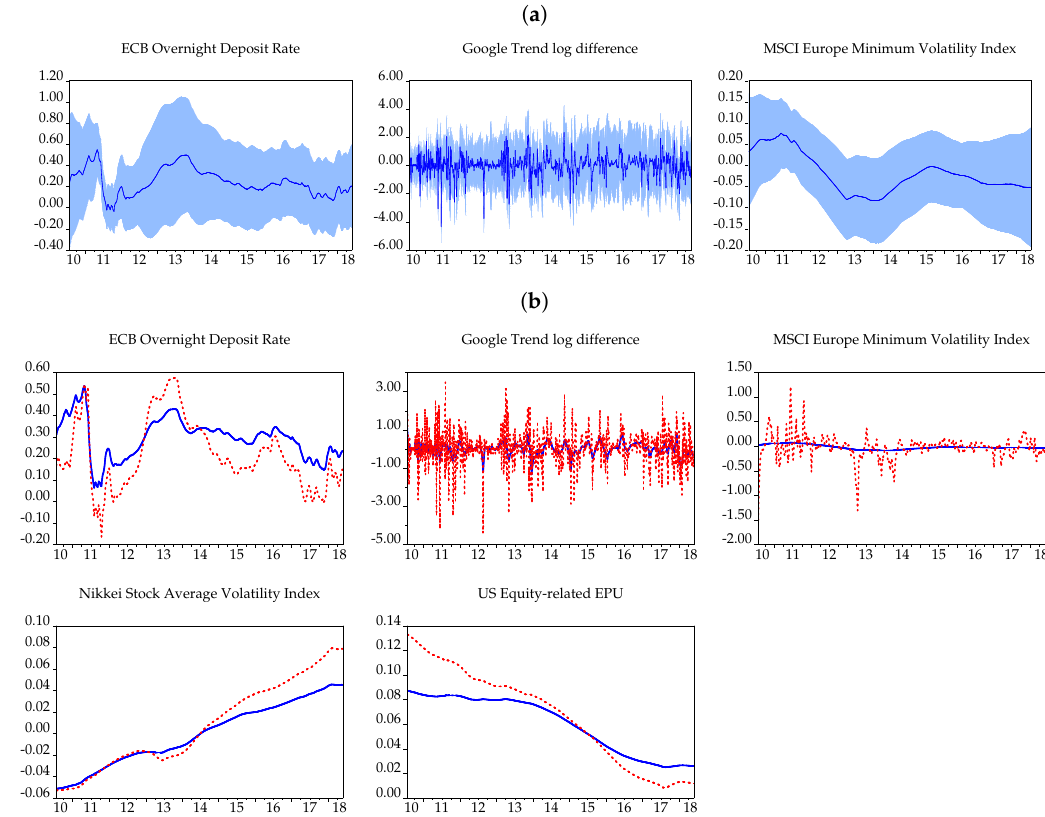
Figure A2. Flexible least squares and state-space varying coefficient paths. ( a ) Flexible least squares with Kalman filtering varying coefficient paths. ( b ) Flexible least squares with Kalman filtering (in blue solid lines) and state-space with Kalman filtering (in red dashed lines) varying coefficient paths. Notes: In panel ( a ) the smoothing parameter has been set to 1; ± 2 standard deviation bands are in light blue. In panel ( b ) the smoothing parameter for the FLS has been set to